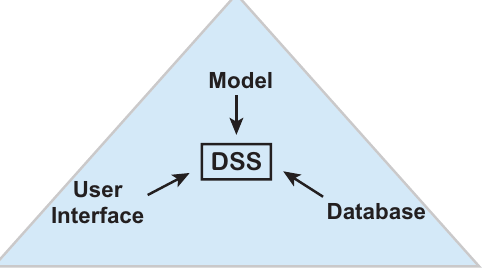
Figure 2. Typical decision support system components